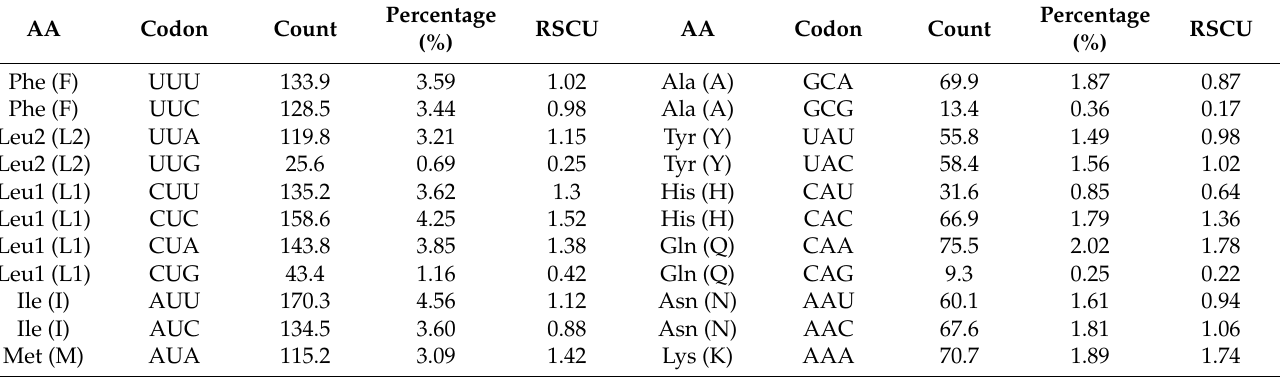
Table 2. The usage of amino acid coding